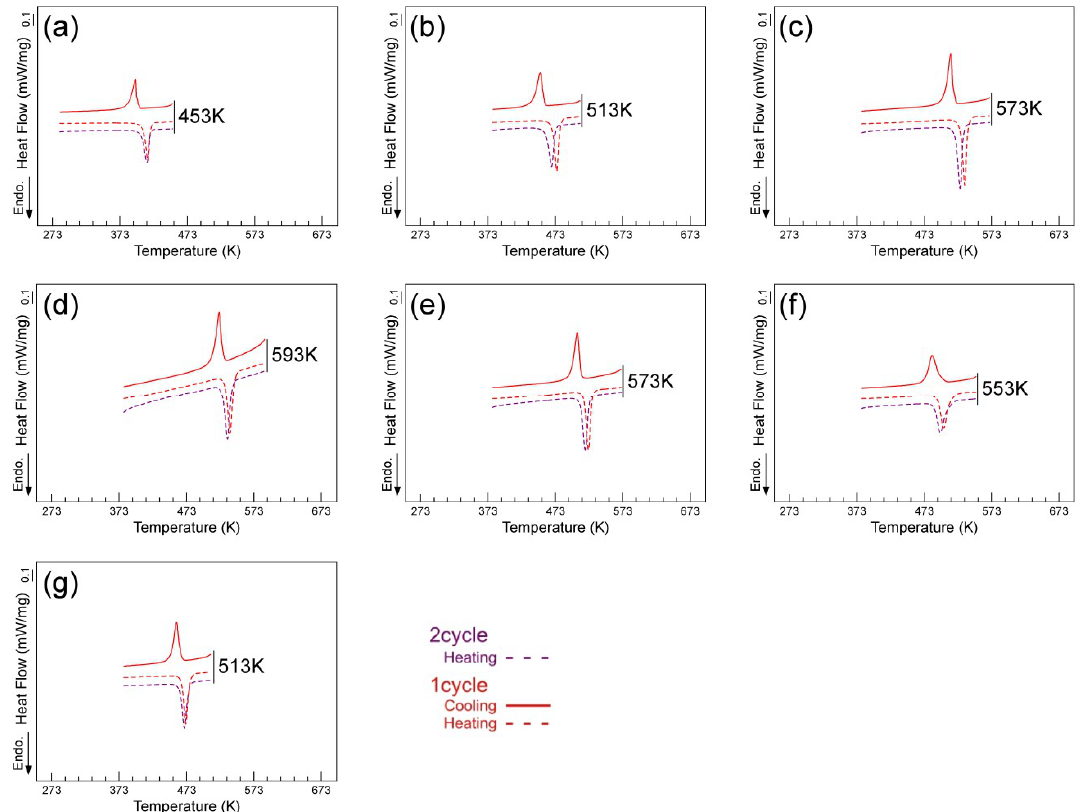
Figure 4. DSC curves of the (49–52)Ti alloys solution treated at 1173 K where the maximum temperature during cycles was adjusted to be about A f + 30 K. ( a ) 49Ti alloy; ( b ) 49.5Ti alloy; ( c ) 50Ti alloy; ( d ) 50.5Ti alloy; ( e ) 51Ti alloy; ( f ) 51.5Ti alloy; ( g ) 52Ti alloy.